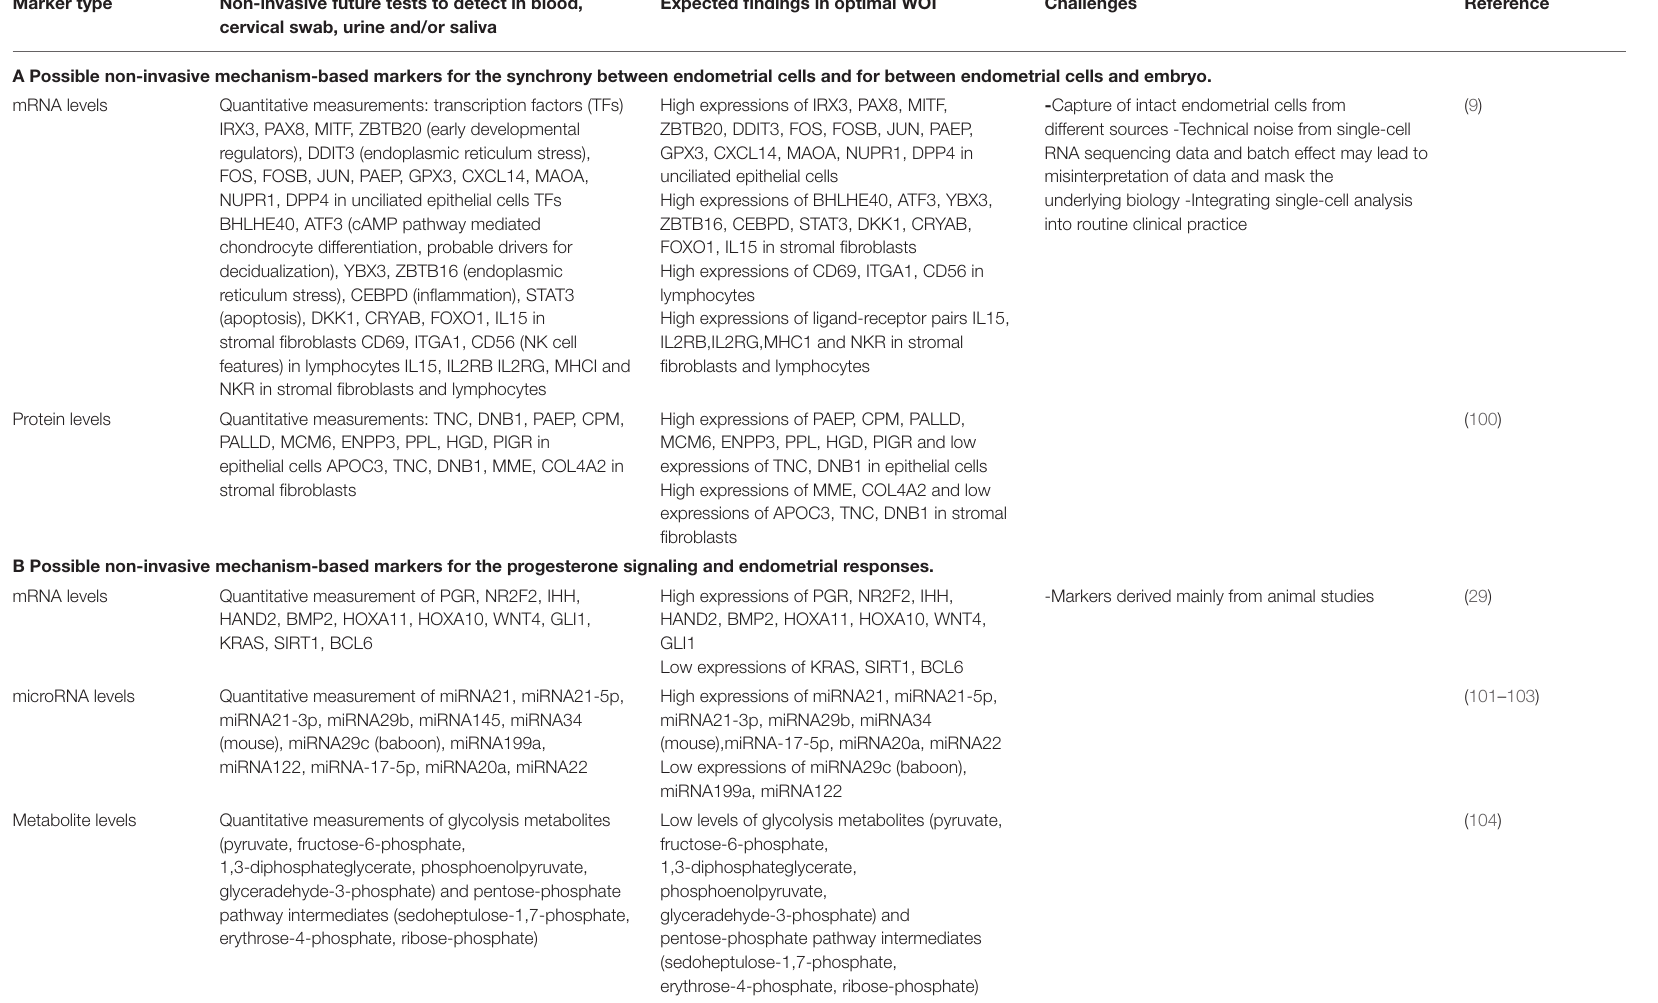
TABLE 2 | Potential mechanism-based markers for the development of non-invasive tests for the window of implantation (WOI). Marker